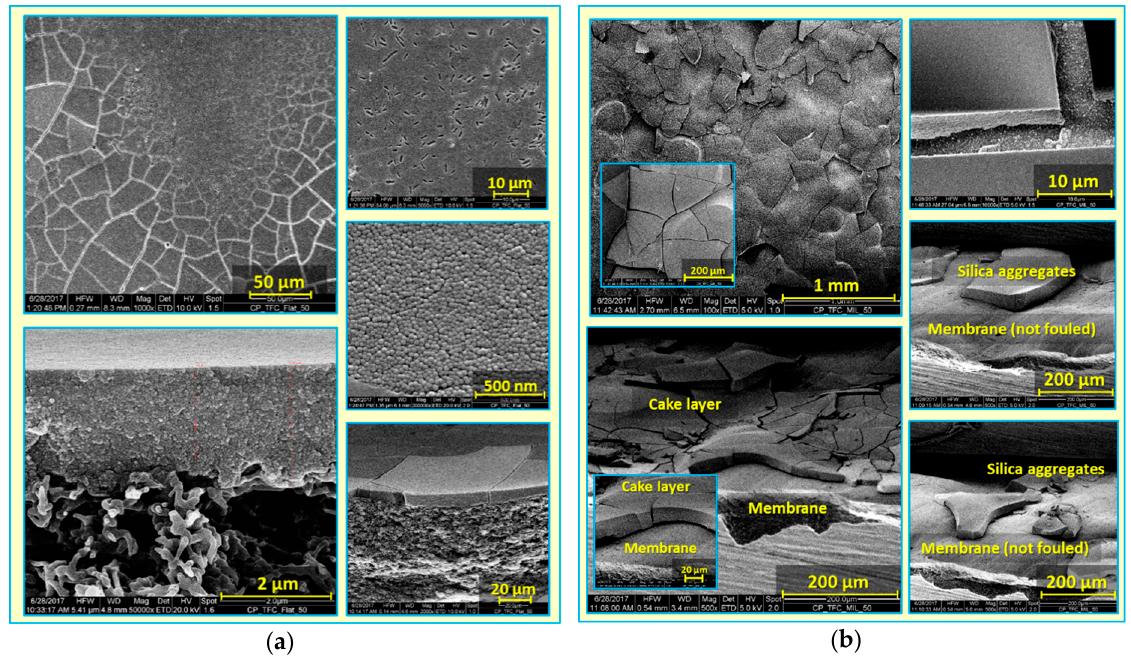
Figure 8. SEM micrographs at different magnifications for colloidal silica fouling of flat ( a ) and micro-patterned ( b ) surface modified membranes using silica nanoparticles (50 nm) in unstirred dead-end filtration conditions.